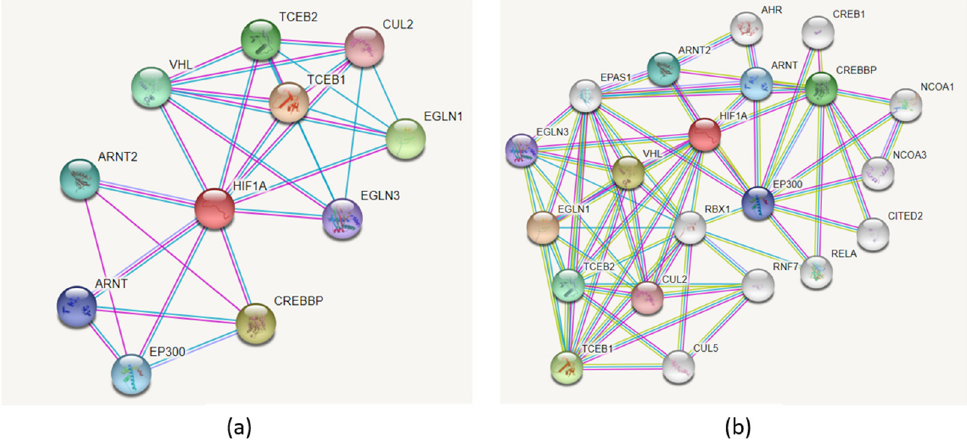
Figure 9. The PPI network associated with HIF1A protein visualized using the STRING tool. ( a ) HIF1A direct interacting partners; the network includes 11 nodes. ( b ) HIF1A extended interaction network with first neighbors consisting of 21 proteins.